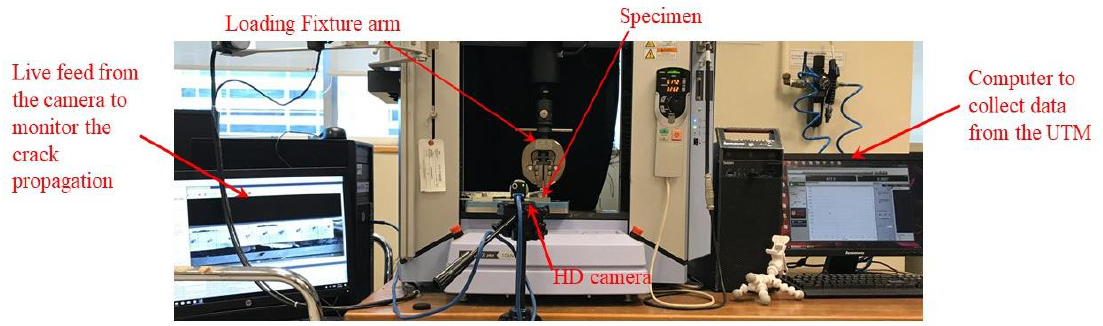
Figure 10. SCB experimental setup on a universal testing machine and associated instrumentation.